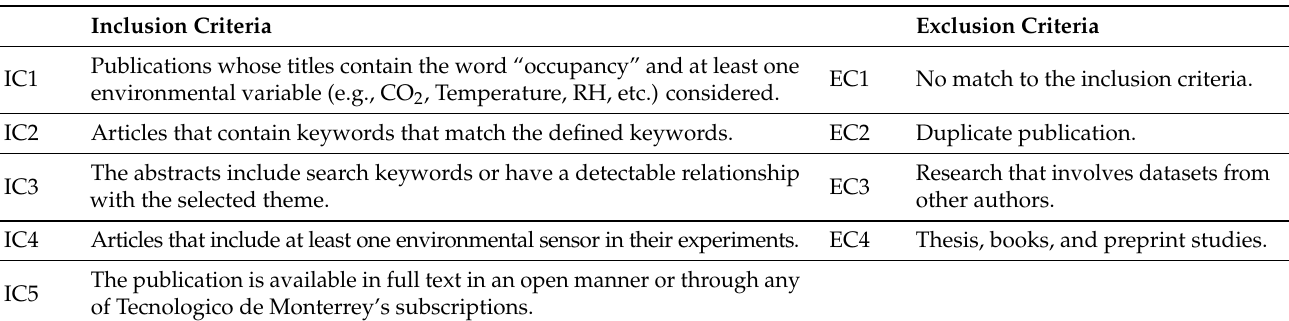
Table 1. Inclusion and exclusion criteria.